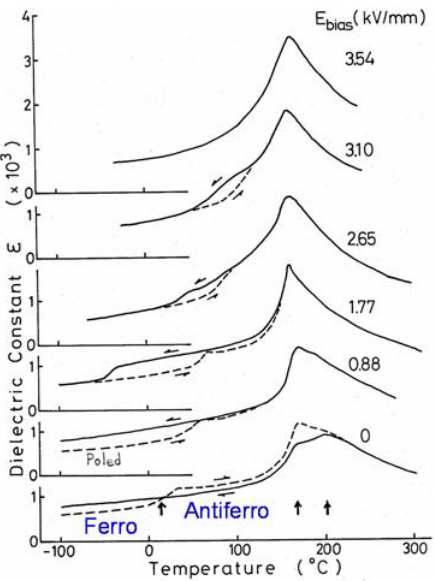
Figure 7. Change of permittivity with temperature under various bias electric field in PNZST (y = 0.06) [7].